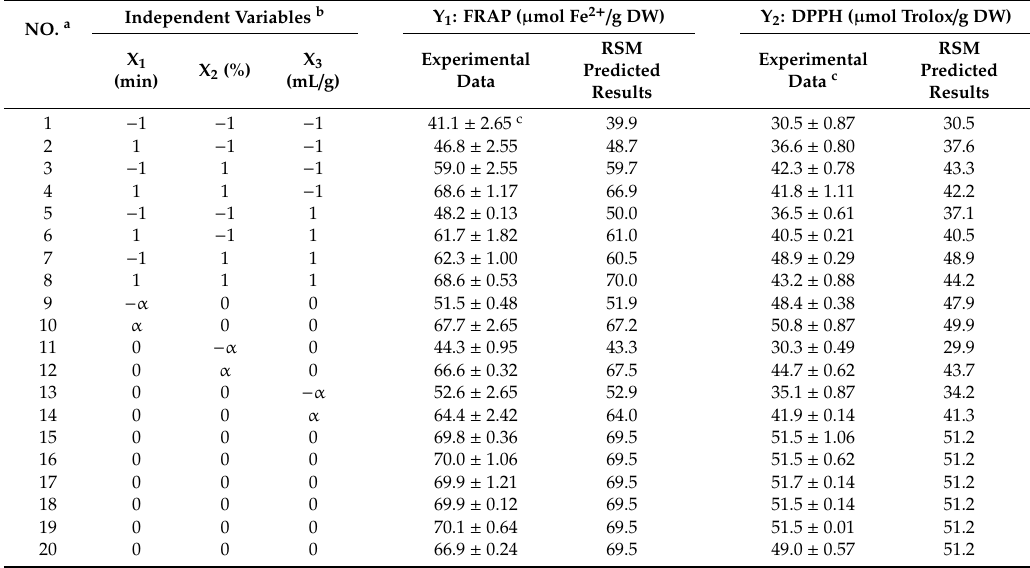
Table 4. Experimental design with response of independent variables.